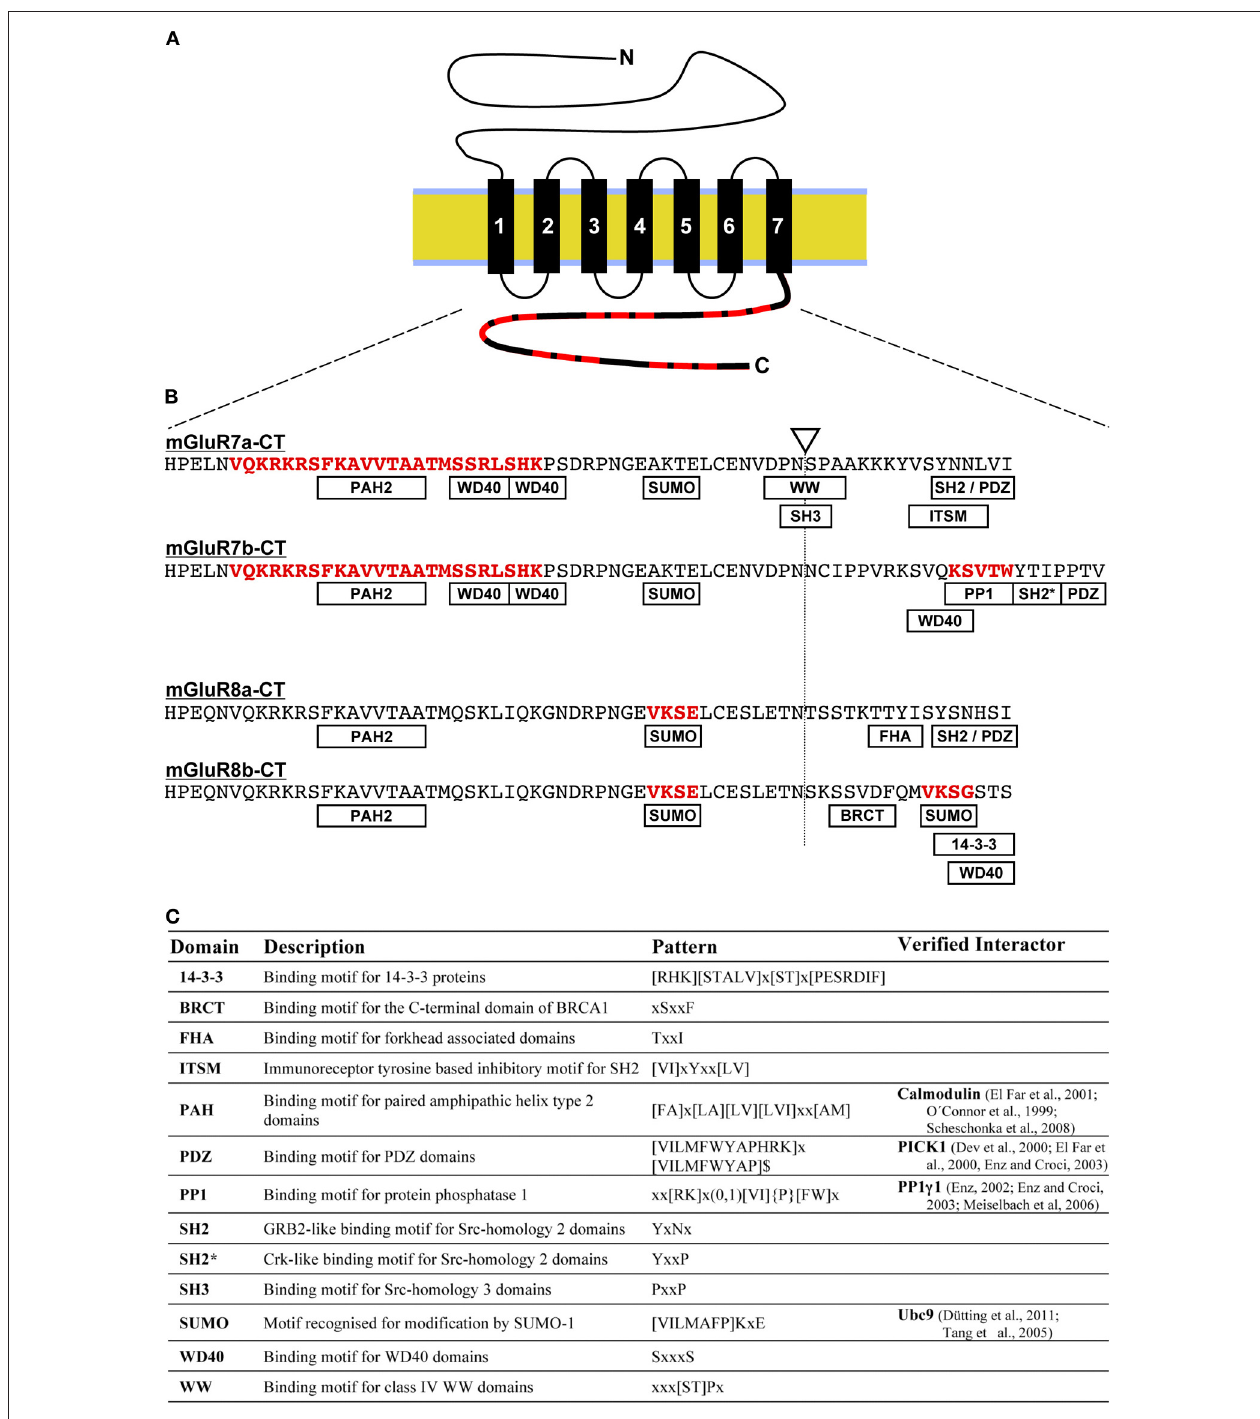
alternative splicing generating a and b variants is indicated by a triangle/dotted line and SLiMs are abbreviated in rectangles. Binding sequences for Calmodulin, PP1, and SUMO proteins that are listed in Figure 2B are highlighted in red (see main text for details). (C) Overview of predicted and experimentally verified sequence patterns of SLiMs shown in (B) and the description of corresponding binding domains. Motifs were identified using pattern-based searches in the ELM databank (Dinkel et al.,